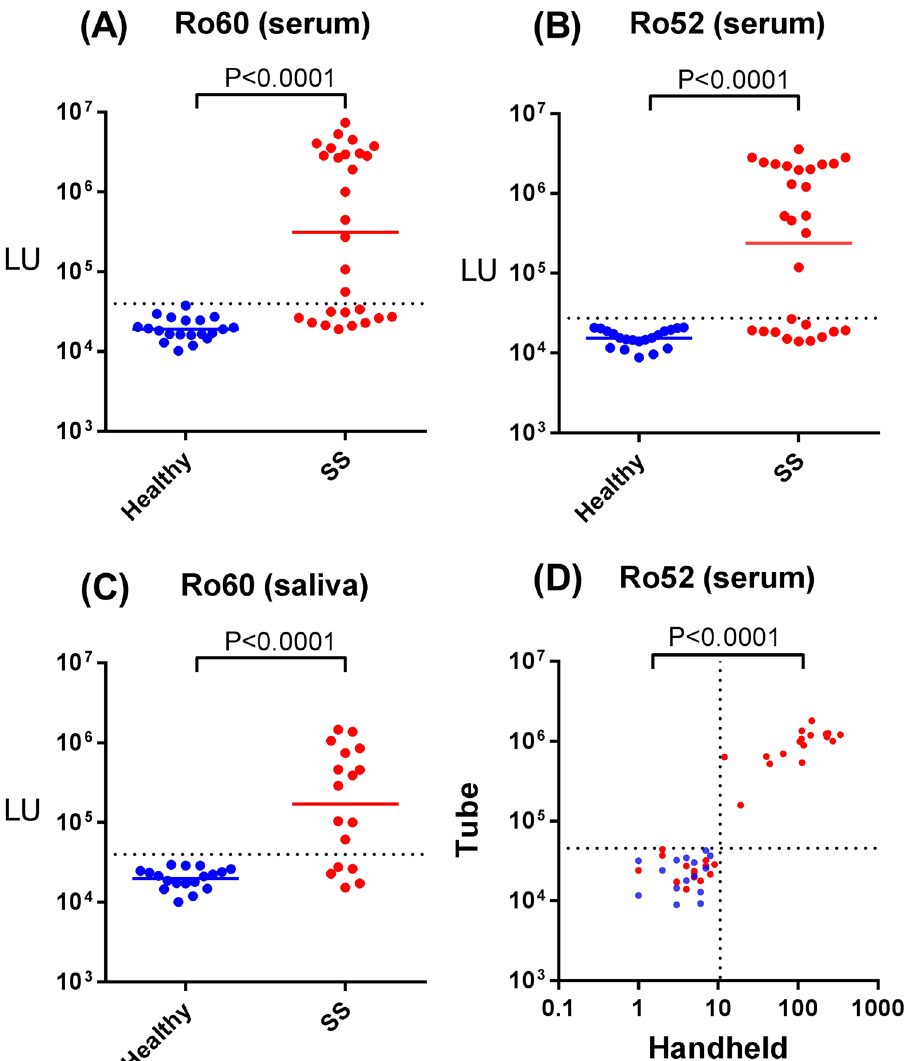
Figure 6. Ultrarapid diagnosis of Sjögren syndrome using serum and saliva. Serum autoantibodies against Ro60 ( A ) and Ro52 ( B ) were detected by LIPSTICKS using Renilla luciferase fusion proteins in healthy controls (blue) and subjects with Sjögren’s syndrome (red). ( C ) Autoantibodies were also detected directly in 10 μ l of saliva (without dilution) by LIPSTICKS in healthy controls (blue) and subjects with Sjögren’s syndrome (red). These results with saliva matched the ELISA using the corresponding serum from these individuals. ( D ) Ro52- NanoLuc fusion protein was used to measure autoantibodies by LIPSTICKS in healthy controls (blue) and patients with Sjögren’s syndrome (red). Shown is the comparison of the detection of the luciferase–generated light with the standard tube luminometer vs. the hand-held luminometer. The correlation coefficient between the values obtained with the two devices was R = 0.73 (p <